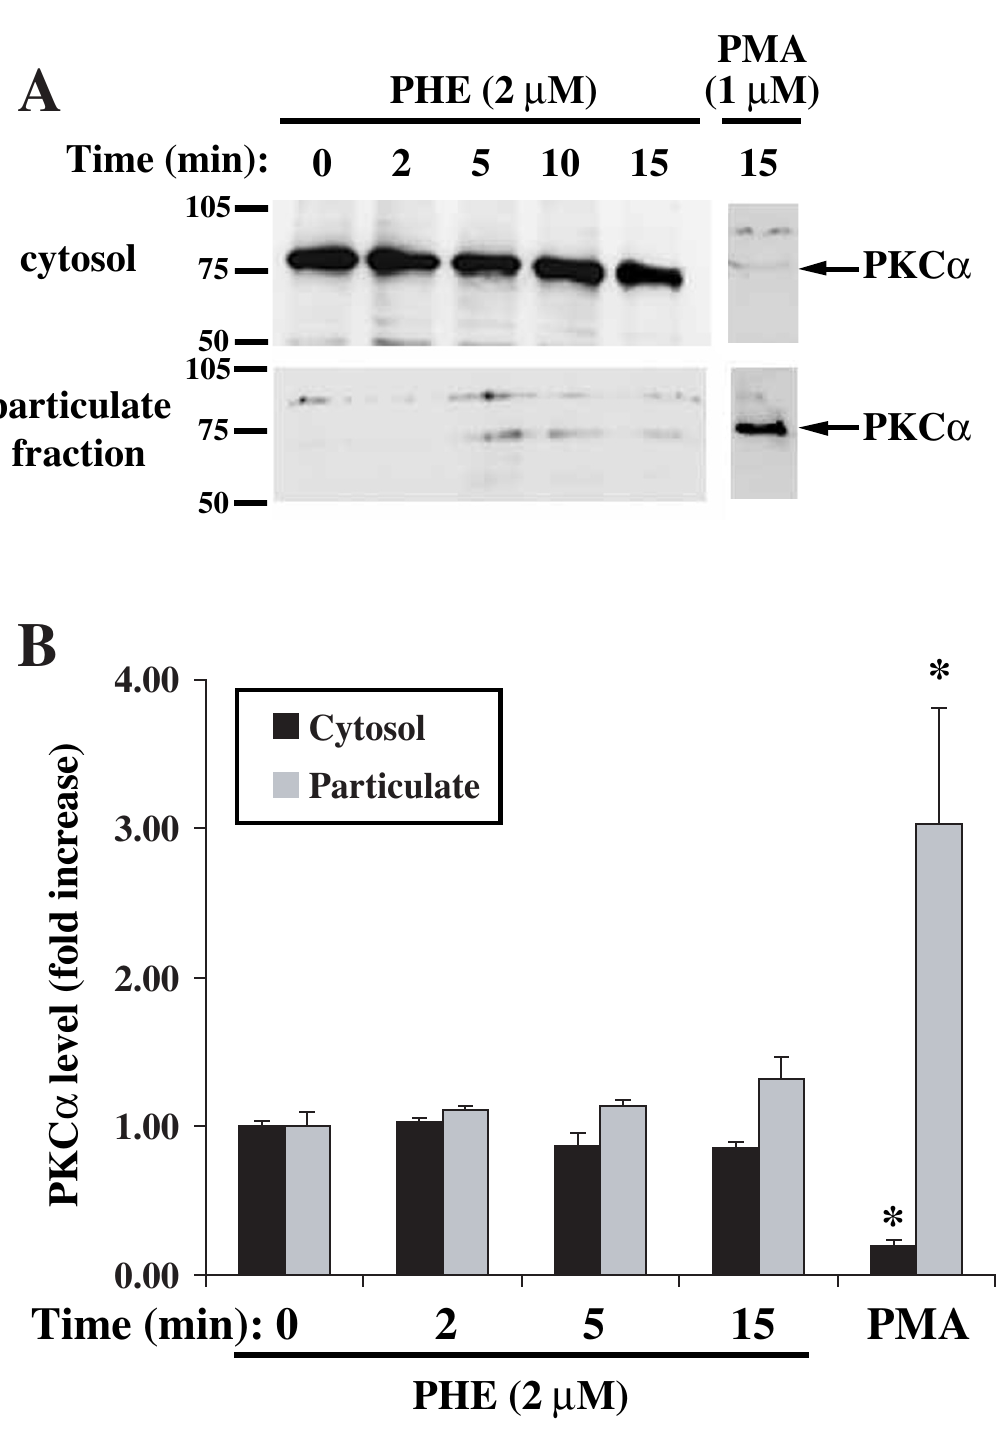
Figure 2 Effect of PHE and PMA on PKC α localization in rat-1 fibroblasts. Serum-deprived cells in DMEM were treated with 2 µ M PHE or 1 µ M PMA for 2, 5, 10 and 15 min, lysed and cytosol and particulate fractions were subsequently prepared as described in methods. A representative Western blot is shown in A. The bar graph (B) represents quantitation of the PKC α protein bands by densitometric analysis of blots from five different experiments. * Value significantly different from time = 0 (cytosol or particulate), p <